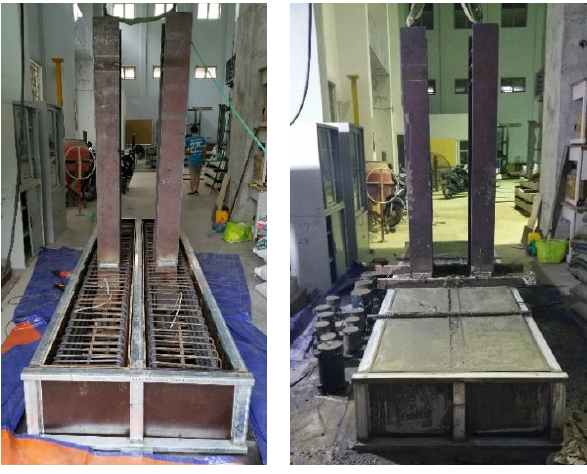
Figure 3. Casting of the specimens.